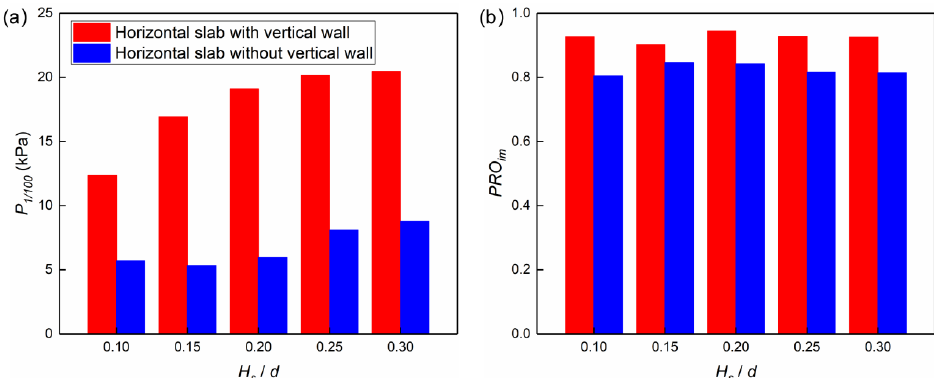
Figure 15. Comparison between the averaged P 1/100 and the impulsive wave impact probability PRO im for a slab with and without the vertical wall, for trials from T16 to T20: ( a ) the averaged P 1/100 on the slab; ( b ) impulsive probability PRO im .